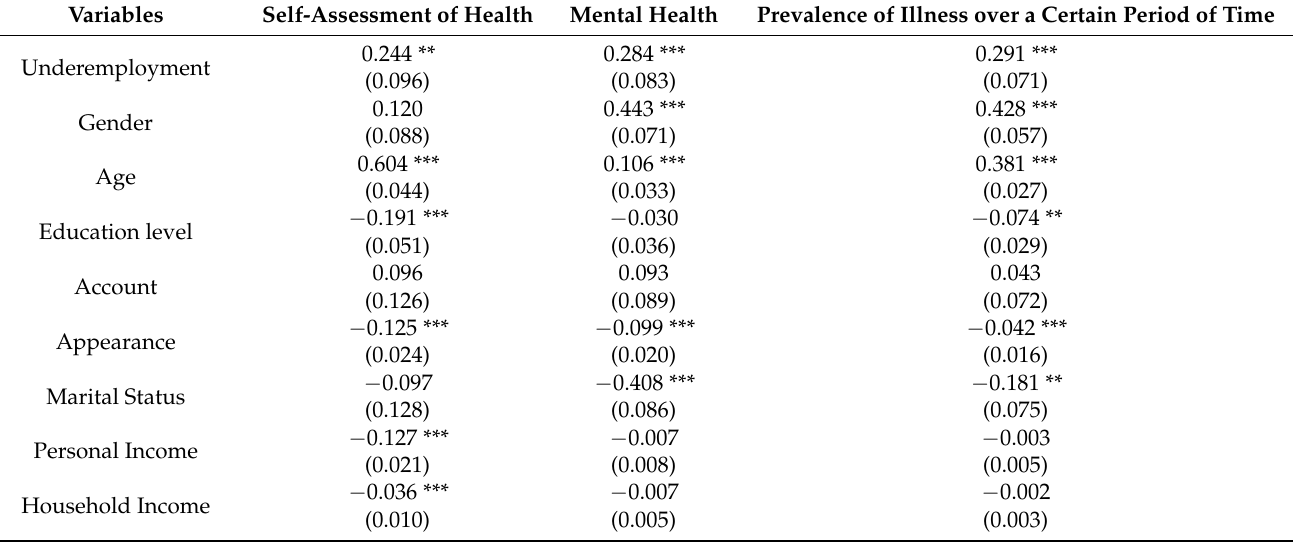
Table 3. Short-term effects of underemployment on workers’